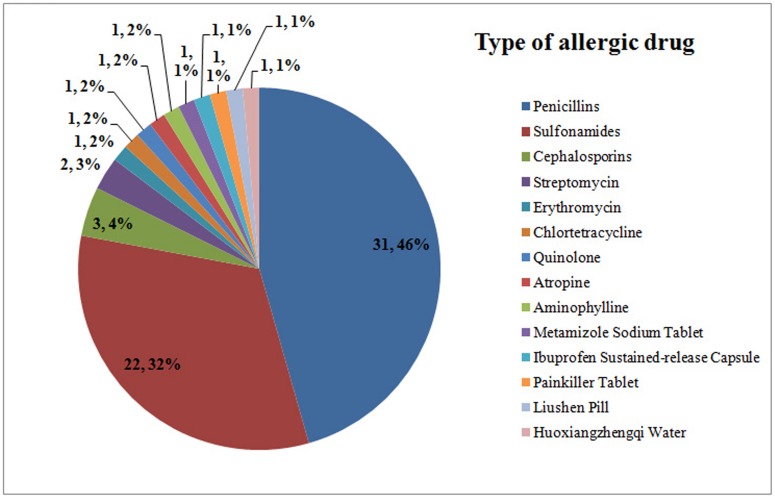
Fifty-eight patients had drug allergy, including 50 patients having allergic reactions to one kind of drug, six patients to two kinds of drugs and two patients to three kinds of drugs.The two numbers indicate the number and percentage of patients.